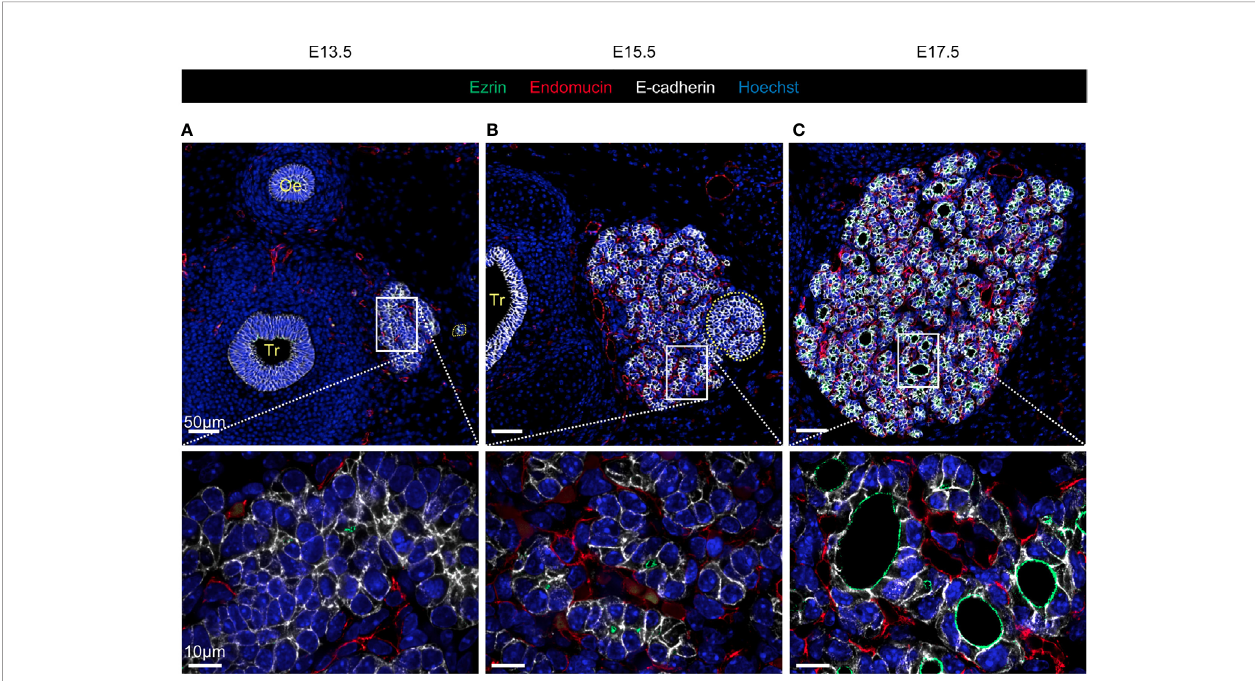
FIGURE 1 | Visualisation of the developing thyroid at three different embryonic stages. Immunolabelling of epithelial cells in white (E-cadherin), endothelial cells in red (Endomucin), and of the apical pole of epithelial cells in green (Ezrin). Nuclei are stained in blue (Hoechst). Tr, trachea; Oe, oesophagus. (A) At E13.5, non-polarised epithelial cells are organised in a multi-layered mass (here, the left thyroid lobe is shown). Sections through endothelial structures are visualised around the thyroid lobe. Magni fi cation revealed that only a few cells present traces of Ezrin labelling, but no intercellular lumen. (B) At E15.5, the thyroid lobe has greatly increased in size and is progressively losing its multi-layered aspect. Dotted yellow line mark the parathyroid gland. Magni fi cation revealed that the thyroid is now fragmented in cords or smaller masses and that epithelial cells are in contact with endothelial cells (red). Ezrin+ structures are now visible and represent the fi rst small interepithelial lumina. (C) At E17.5, the thyroid has reached an almost mature con fi guration, with epithelial cells organised in monolayers around a central lumen (follicular lumen in green) and surrounded by a dense network of endothelial cells